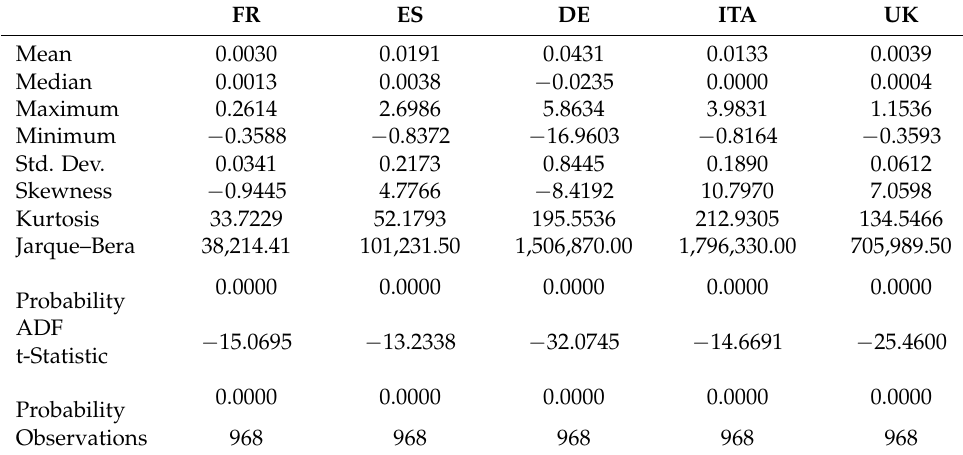
Figure 1. Electricity prices in five European countries. To ensure the stationary of the data used for modeling, the daily return of each electricity price is calculated. The descriptive statistics and stationary tests are shown in Table 1. It can be found that the average electricity returns of the five countries are all greater than 0, among which the highest average daily growth rate in Germany is 4.31%, while its volatility is also the highest among the five countries. Meanwhile, the results of the ADF test showed that all the data are stationary. The results of the correlation analysis are shown in Table 2; the electricity return in France and Britain, Spain and Italy show a significant positive correlation. Table 1. Descriptive statistics and stationary tests of electricity return.